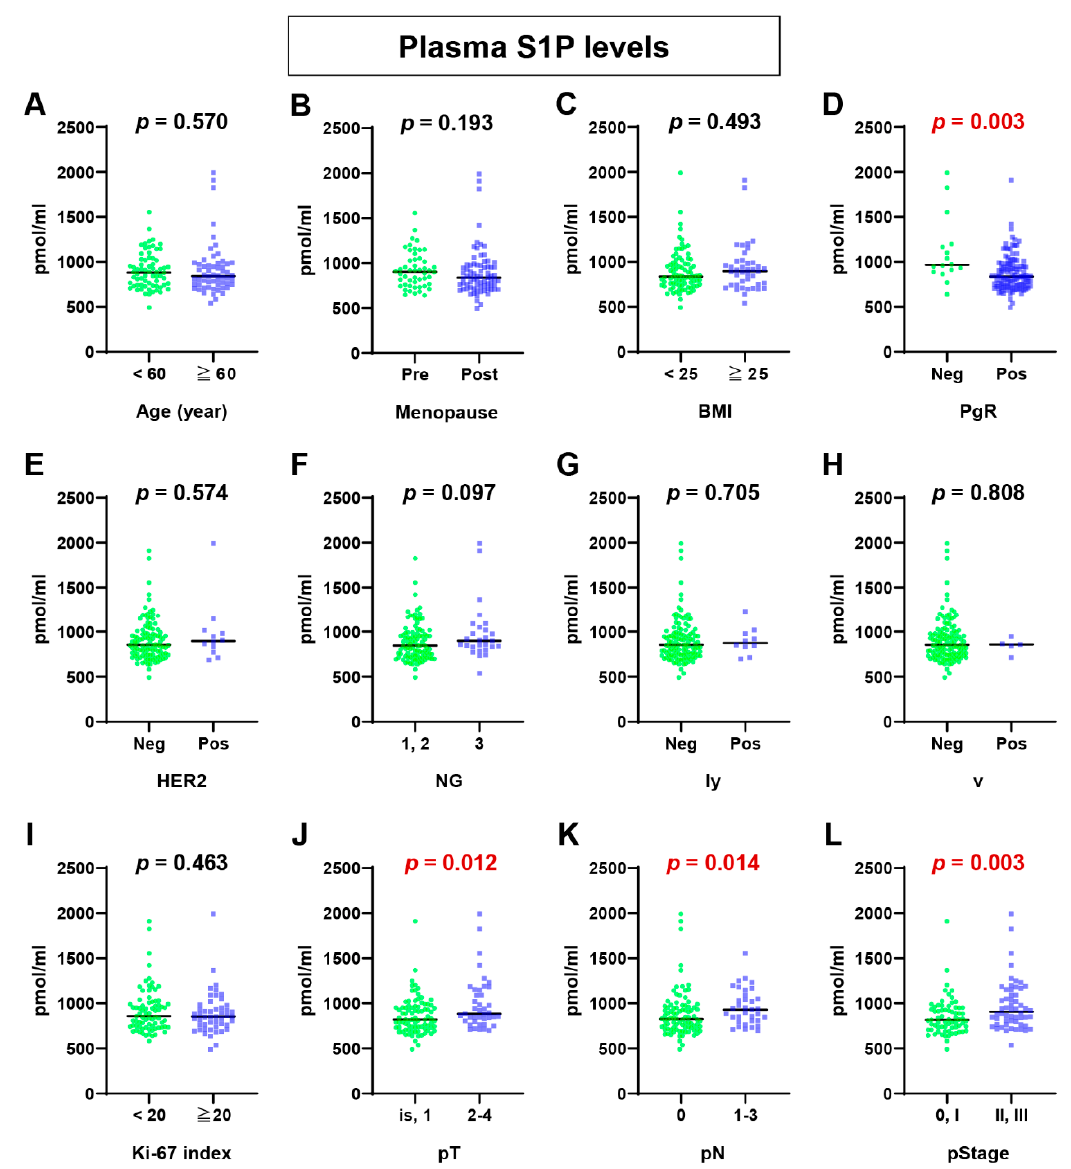
Figure 1. Sphingosine-1-phosphate (S1P) levels in plasma of estrogen receptor-positive breast cancer patients. S1P levels were determined by mass spectrometry and compared between patients of <60 years and ≥ 60 years ( A ); premenopause (Pre) and postmenopause (Post) ( B ); body mass index (BMI) <25 or ≥ 25 ( C ); negative (Neg) and positive (Pos) for progesterone receptor (PgR) ( D ); negative and positive for HER2 expression/amplification ( E ); NSAS nuclear grade (NG) 1, 2, or 3 ( F ); negative and positive for lymphatic invasion (ly) ( G ); negative and positive for vascular invasion (v) ( H ); Ki-67 labeling index <20 and ≥ 20 ( I ); pathological primary tumor (pT) 1 and 2–4 ( J ); pathological regional lymph node (pN) 0 and 1–3 ( K ); pathological stage (pStage) 0, I, II, and III ( L ). Horizontal lines indicate median values. The Mann–Whitney U test was performed for statistical analysis, in which all tests were two-sided, and p -values < 0.05 were considered statistically significant (shown in red color).